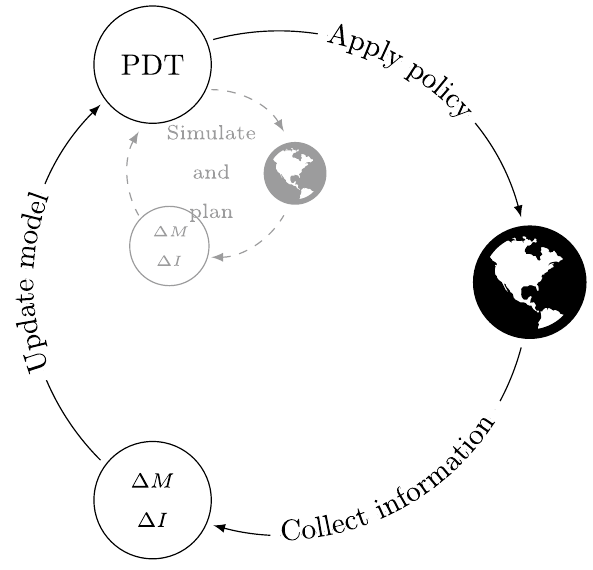
Fig. 3 A PDT as a mental model of an agent taking actions in the real world. As new experience is gained, the PDT may be updated by changing the structural assumptions M that defined the prob- ability measure P , or updating belief with respect to epistemic events through conditioning on the new set of information I . The changes in structural assumptions and epistemic information are represented by Δ M and Δ I respectively. As part of the planning pro- cess, the PDT may simulate possible scenarios as indicated by the inner